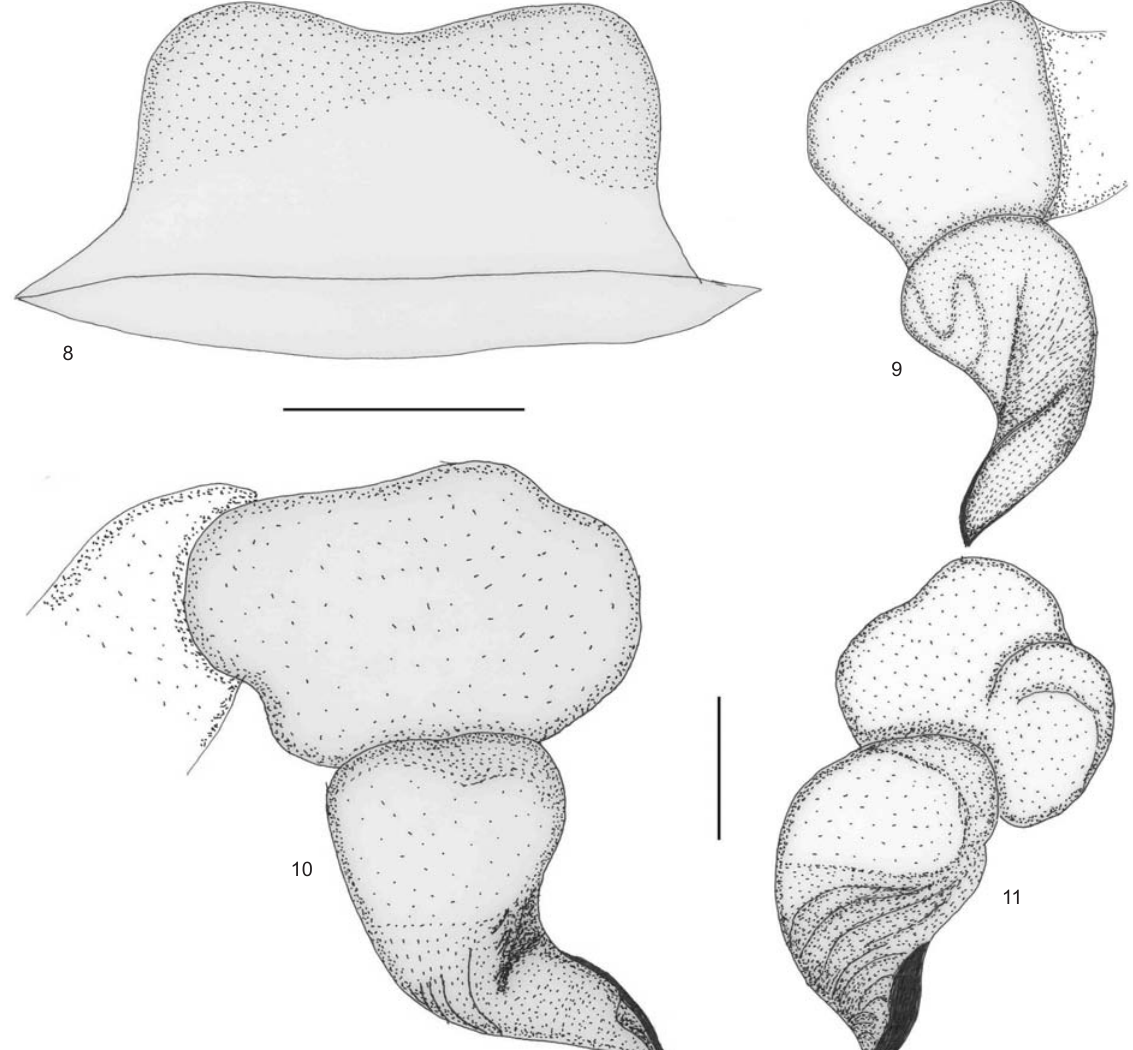
8.06 wide. Spinnerets: PMS, 1.50 long, 0.58 wide, 0.60 apart; PLS, 2.08 basal, 1.76 middle, 2.02 distal; midwidths, 1.06, 0.98, 0.60 respectively; 5.86 total length.